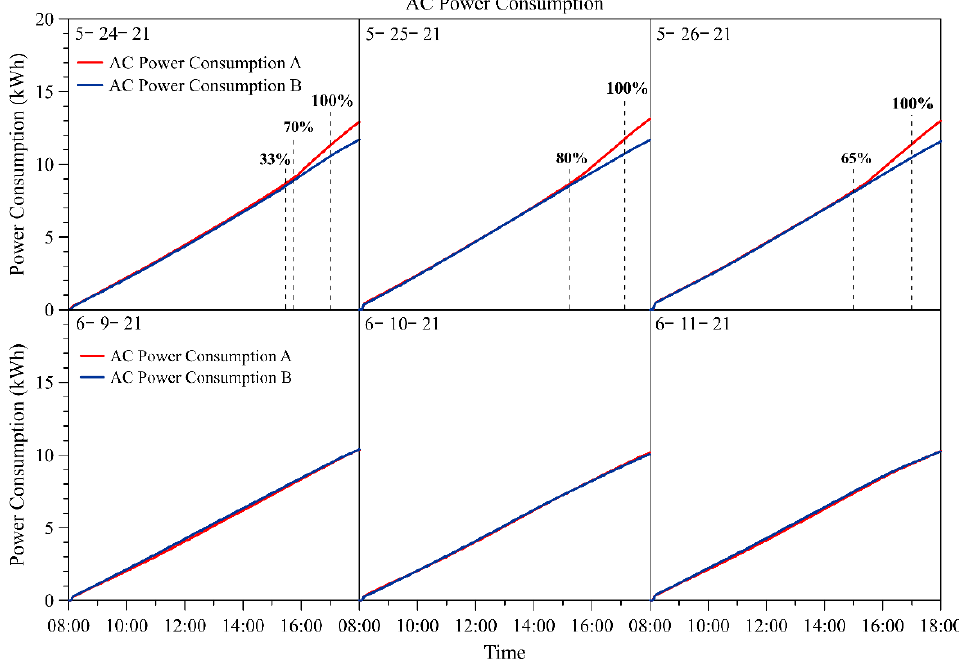
Figure 10. Cumulative AC Power Consumption History of Room A and Room B.